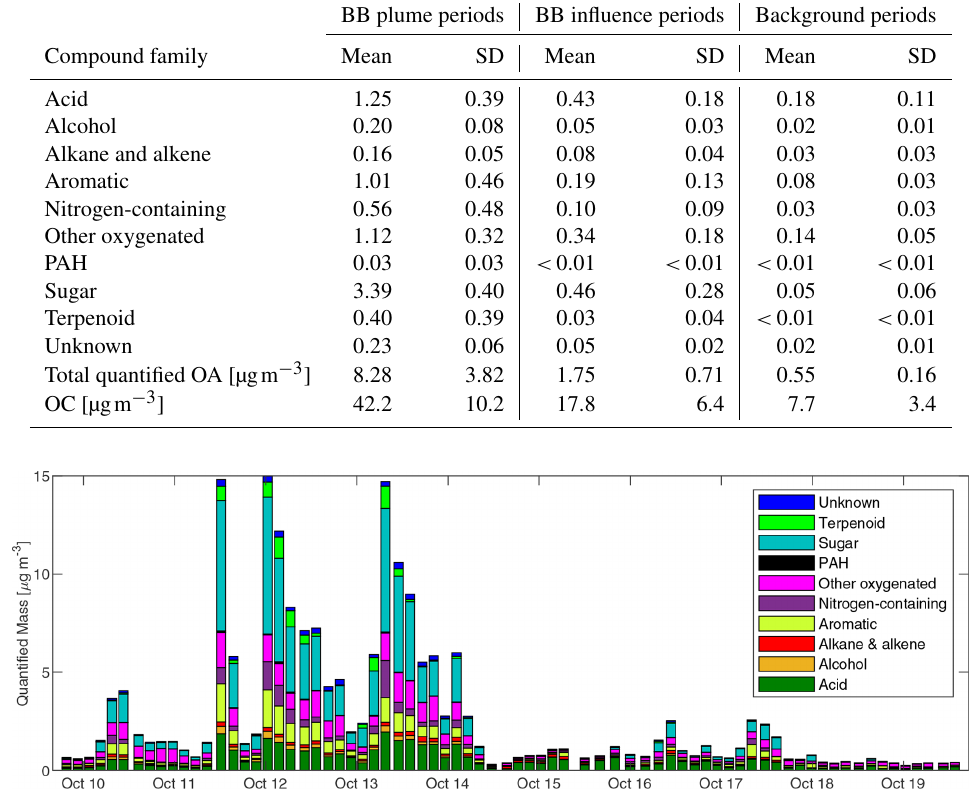
Table 1. Concentration of each chemical family, total quantified OA by GC × GC, and OC [µgm − 3 ] of the three regimes. Standard deviation is indicated as “SD”.